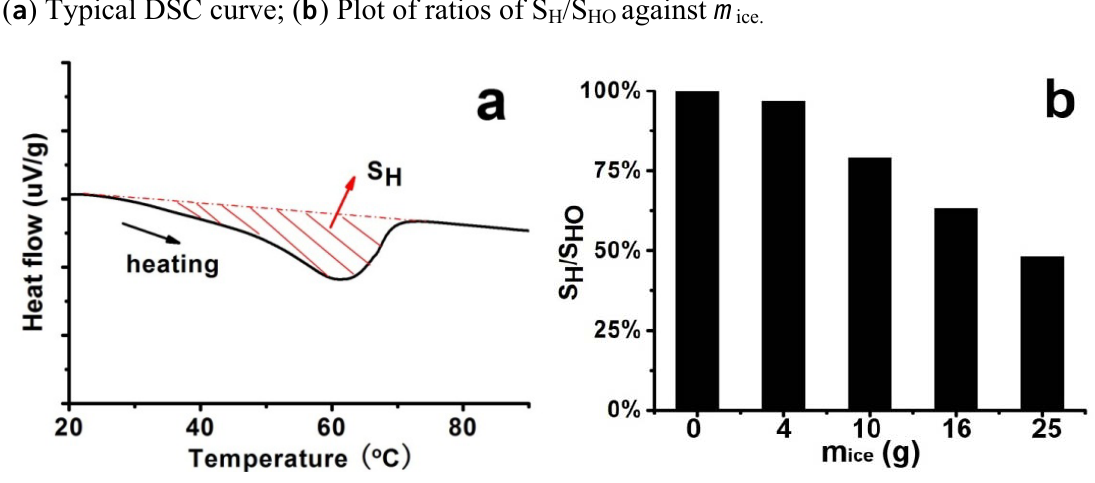
) H ) by fixing 5% ice